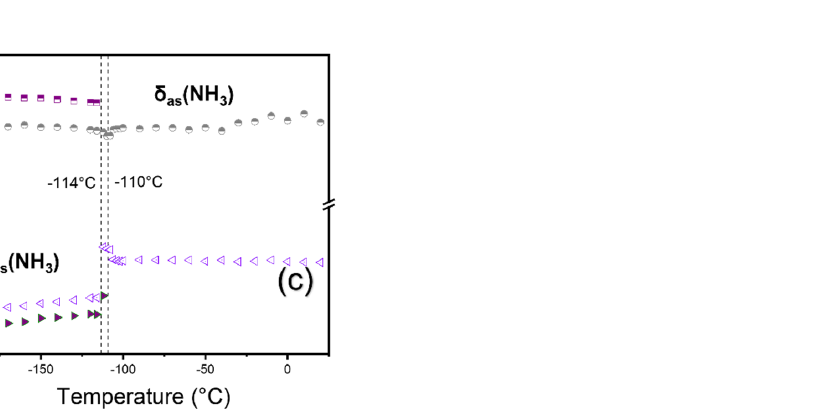
Figure 7. (Color online) Temperature dependences of the Raman shift in a 400–1700 cm − 1 frequency range ( a – c ). Phase boundaries are shown as vertical dotted lines along with the phase transition temperatures.